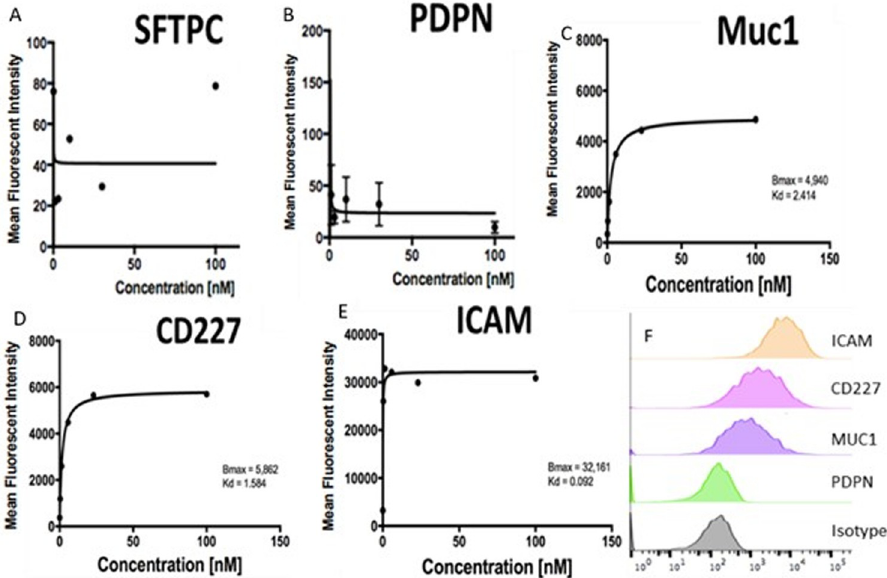
Fig 2. Antibody Binding Curves of antibody concentration (x axis) versus Mean Fluorescence Intensity (MFI) (y axis) demonstrating receptor density (B max ) and antibody-antigen affinity (K d ). A) Surfactant Protein C (SFTPC) B) Podoplanin (PDPN) (SFTPC and PDPN did not fit a curve, thus B max and Kd calculations were not possible). C) Muc 1 D) CD 227 (second clone of Muc 1 antibody) E) Intracellular Adhesion Molecule 1 (ICAM). F) Comparison of MFI distribution at an antibody concentration of 30 nM of each antibody